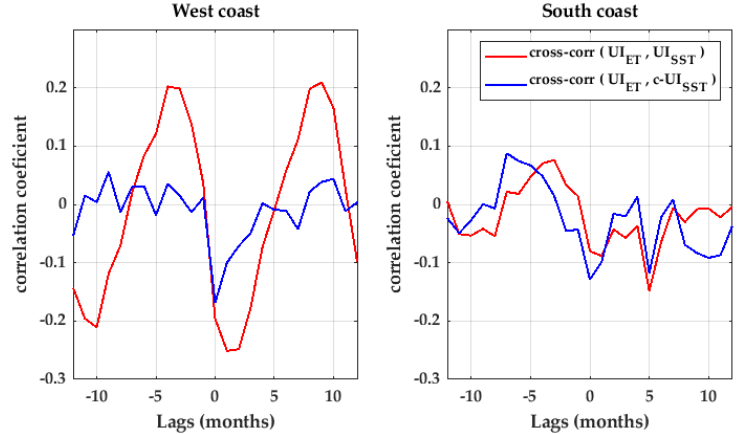
Figure 11. Cross-correlation between the UI ET and the UI SST time series (red line) and between the UI ET and the c-UI SST time series (blue line). UI ET and the c-UI SST time series (blue